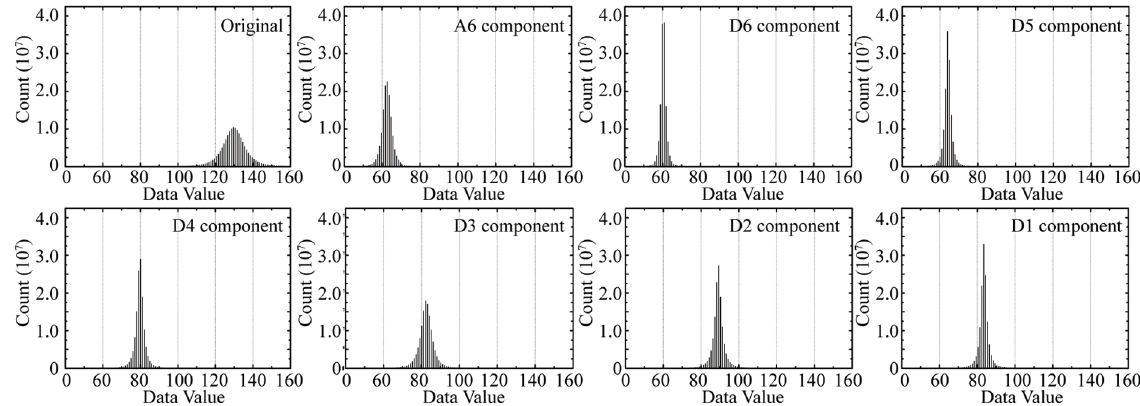
Figure 5. The histogram of the original data and the decomposed